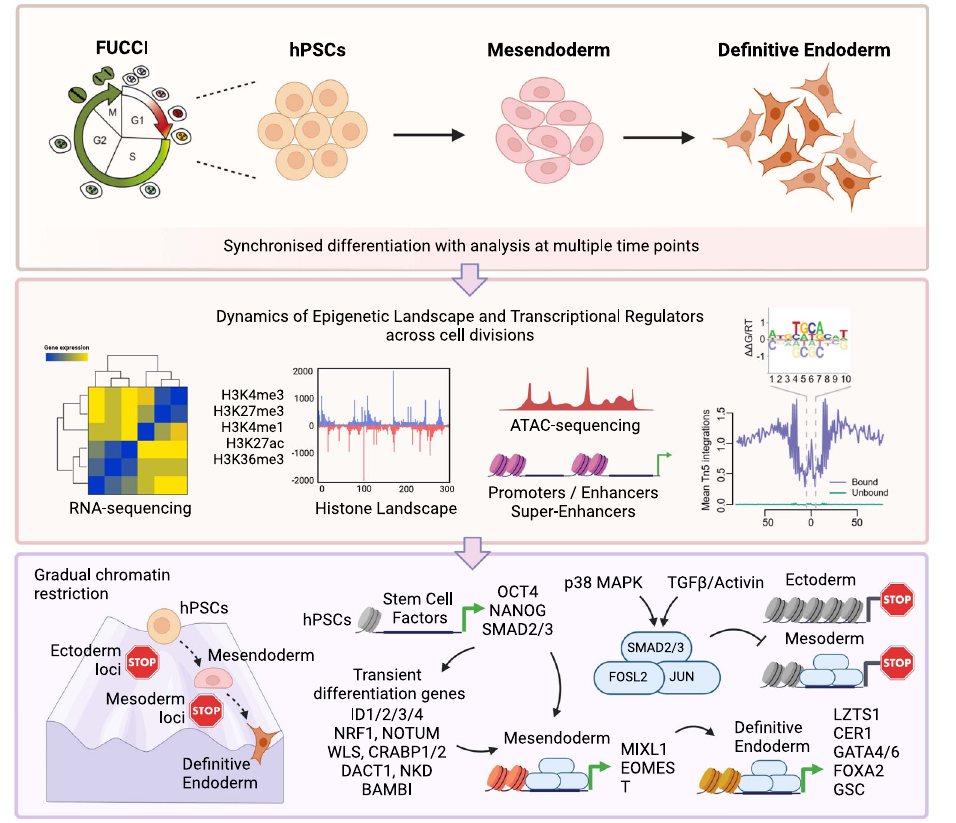
Fig. 7 | Schematic depiction of the study design, analyses methods and results from synchronised hPSC differentiation to de fi nitive endoderm. We took advantage of the Fluorescent Ubiquitination-based Cell Cycle Indicator (FUCCI) reporter to develop a culture system allowing the differentiation of human embryonic stem cells (hESCs) synchronised in their early G1 phase of the cell cycle toassesstheepigenomeandtranscriptomedynamicsduringthe fi rsttwodivisions leading to de fi nitive endoderm. Our data comprise multiple time points spanning